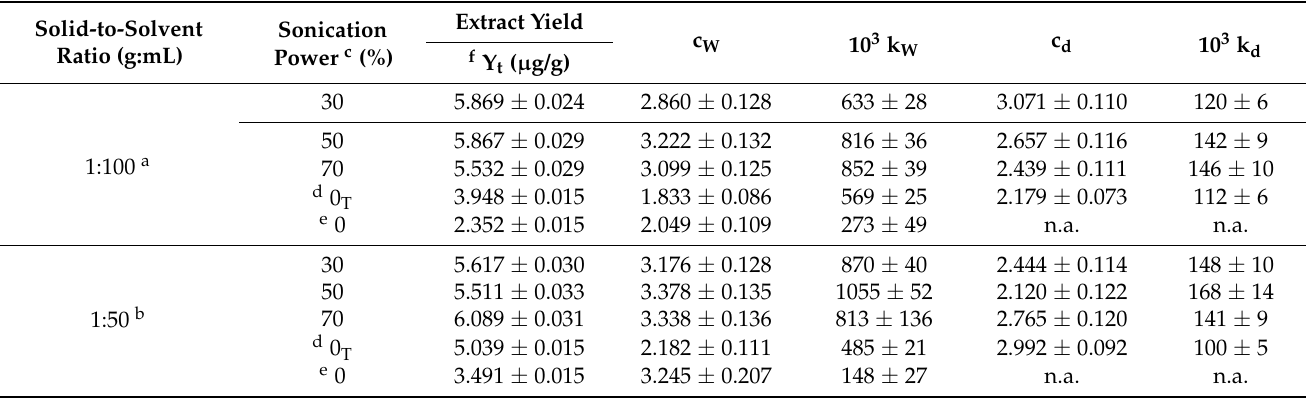
Table 1. The extract yield, Y t of the extraction in the presence and absence of ultrasound. The values of c w , k w , c d and k d .